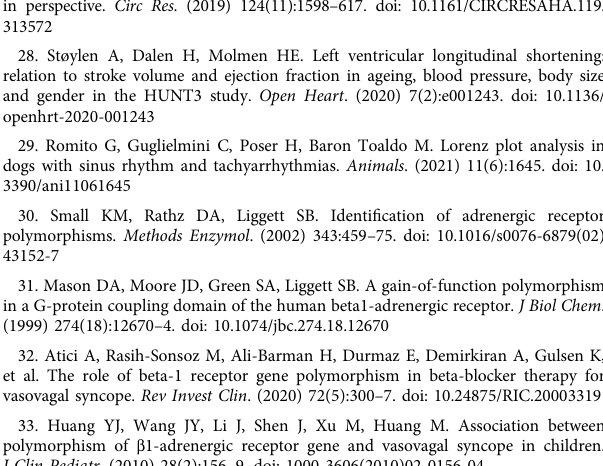
table test. Int J Environ Res Public Health . (2020) 17(12):4524. doi: